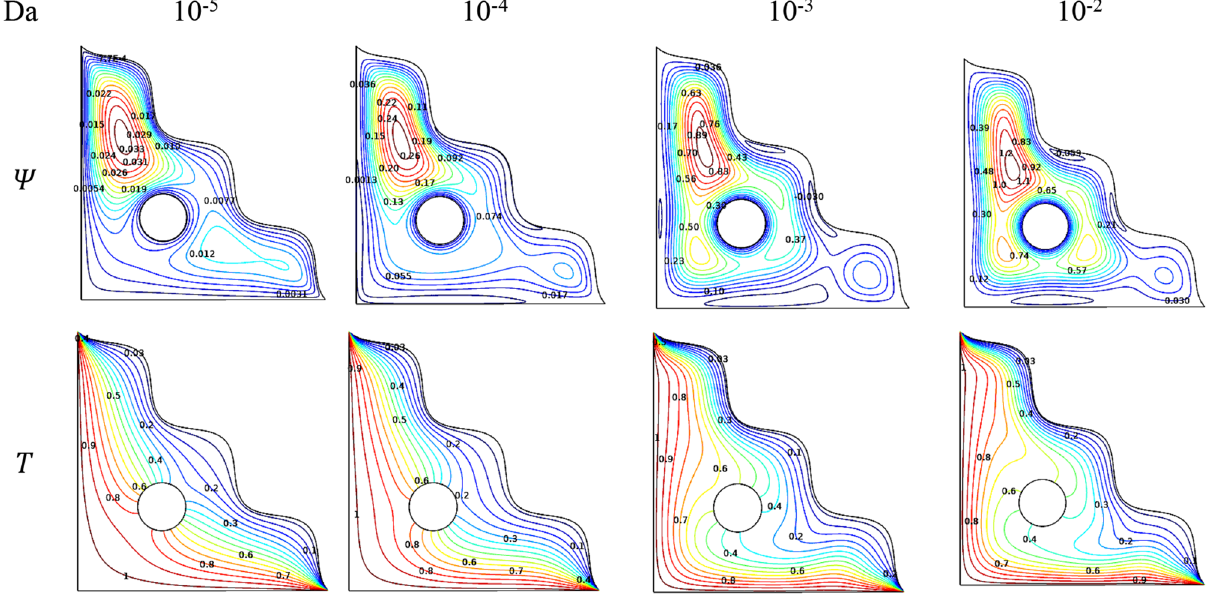
Figure 14. Variations of the streamlines ( (cid:31) ) and isotherms ( T ) with various Ha , Ra = 10 6 , φ = 0.02 , ω = 0 , N = 4 , r = 0.1 and ε = 0.2